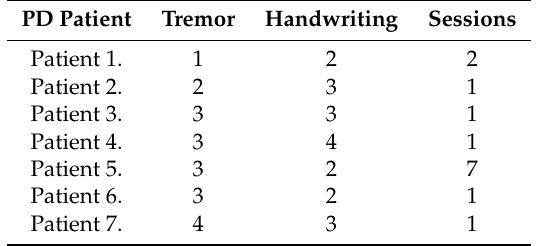
Table 1. Fahn–Tolosa–Marin tremor rating scale values of the